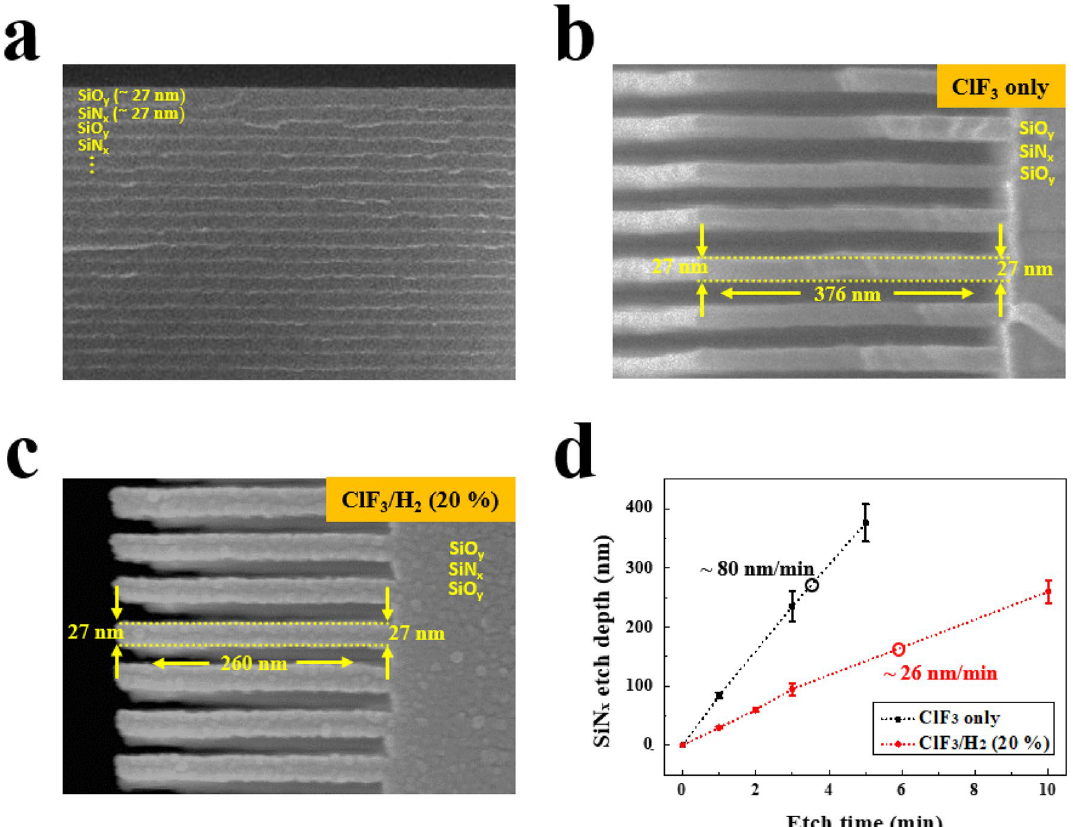
Figure 6. Etch characteristics of ClF 3 only and ClF 3 /H 2 (20%) plasma in stacked SiN x /SiO y . ( a ) SEM images of reference stacked SiN x /SiO y . Etch profile of stacked SiN x /SiO y after the etching with ( b ) ClF 3 plasma and ( c ) ClF 3 /H 2 (20%) for 5 min and 10 min, respectively. ( d ) Etch depth of SiN x in the stacked SiN x /SiO y with etch time for ClF 3 and ClF 3 /H 2 (20%)